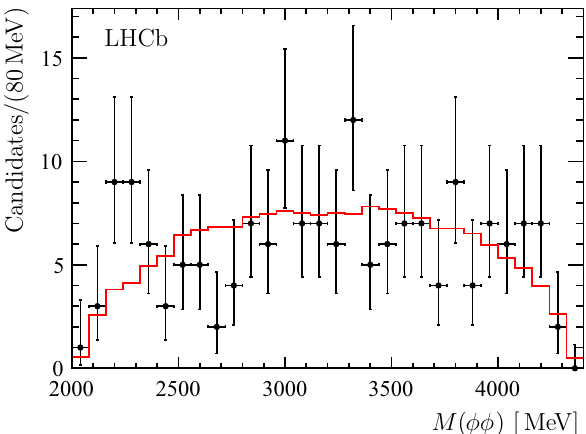
Fig. 11 The φ meson angular distribution for the B 0 s → φφφ candi- dates ( points with error bars ) with the overlaid distribution from the simulation with no polarization ( red solid histogram ) and two extreme, transverse ( green dashed histogram ) and longitudinal ( blue dotted his- togram ),